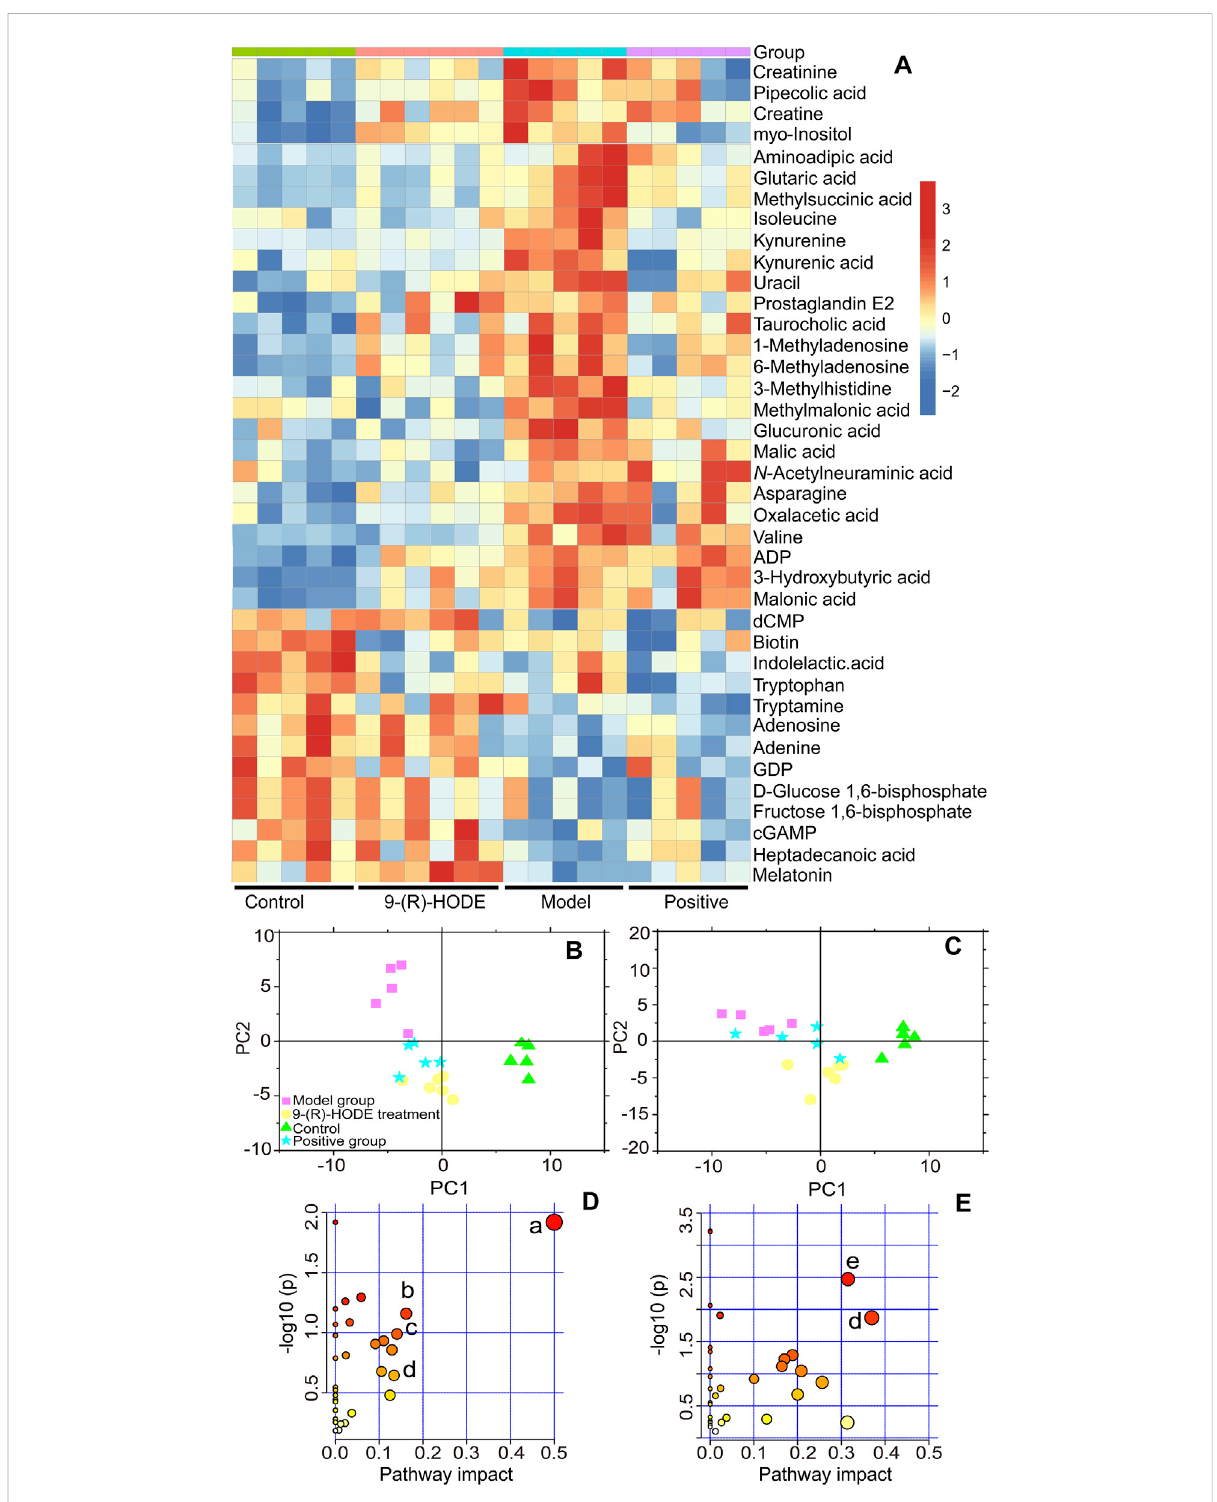
FIGURE 3 (A) Representativeextractedheatmapofdifferentialaqueous-solublemetabolitesintheliver.Thecolorscaleillustratestherelativeabundances acrossthesamples.Blueindicatesmetabolitesthatweresigni fi cantlydownregulated,whileredindicatessigni fi cantlyupregulatedmetabolites. (B,C) PLS-DA score plots of PC1 vs. PC2 based on the LC ‒ MS/MS data of aqueous-soluble metabolites in liver (B) and muscle (C) . (D) Pathway analysis of metabolites in the liver. The node color is based on its p value, and the node radius is determined based on their pathway impact values, (a) ascorbate and aldarate metabolism; (b) citrate cycle; (c) lysine degradation; (d) and tryptophan metabolism. (E) Pathway analysis of metabolites in muscle. (e) Alanine, aspartate and glutamate